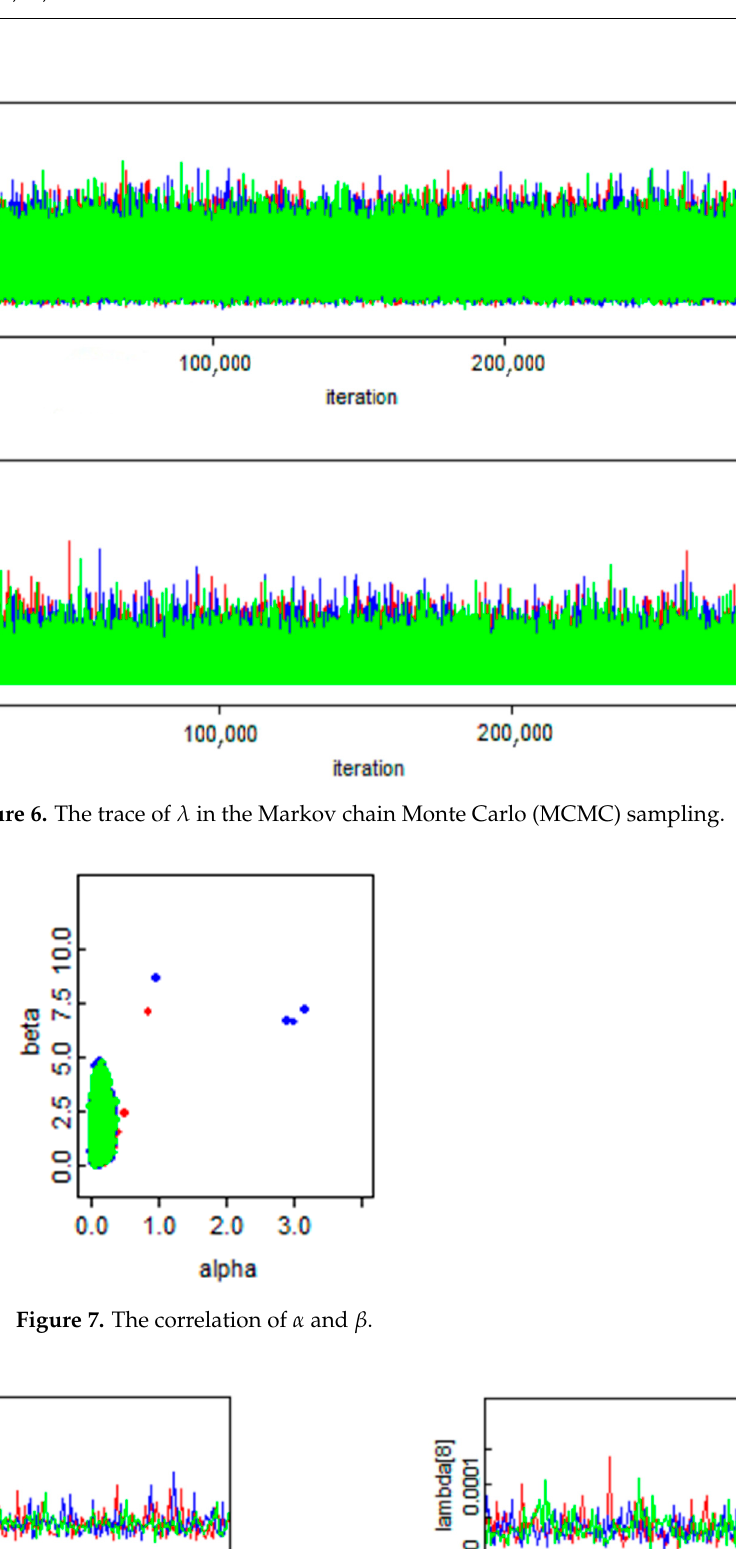
Figure 5. Density functions for (cid:2009) , (cid:2010) , and (cid:2245) .